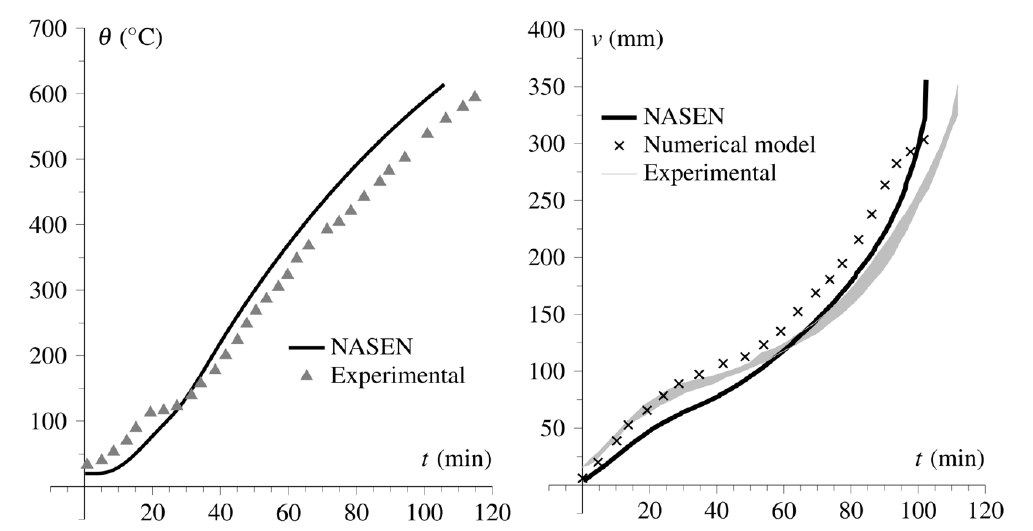
Figure 11. Evolution of temperature and deflection at mid-span of the composite beam as a function of time of exposure to fire.